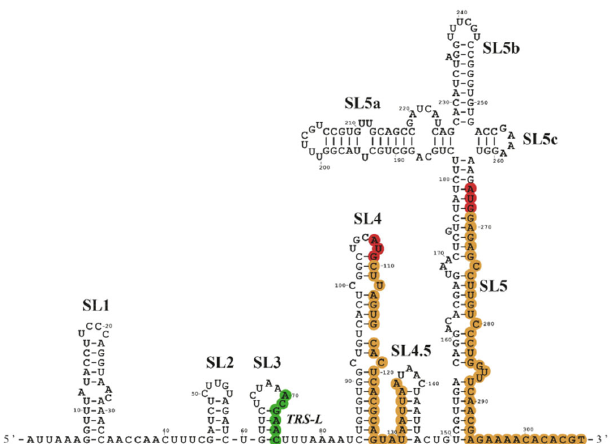
Figure 2. Modelization of the structure of the SARS ‐ CoV ‐ 2 gRNA 5 ′ UTR. This model, adapted from Miao et al. (2021) [73], shows the different stem ‐ loop (SL) RNA structures. Position of the AUG codons of uORF and main ORF are highlighted in red, the coding region in orange and the TRS ‐ L in green.